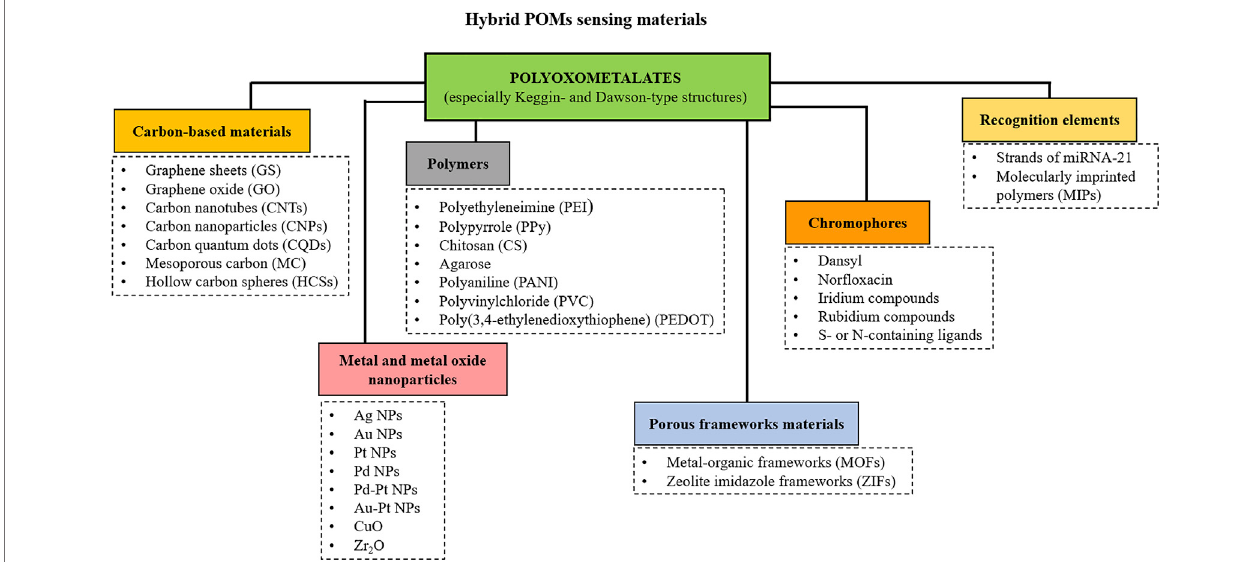
FIGURE 5 | Summary of the most reported materials used in polyoxometalate functionalized sensors.